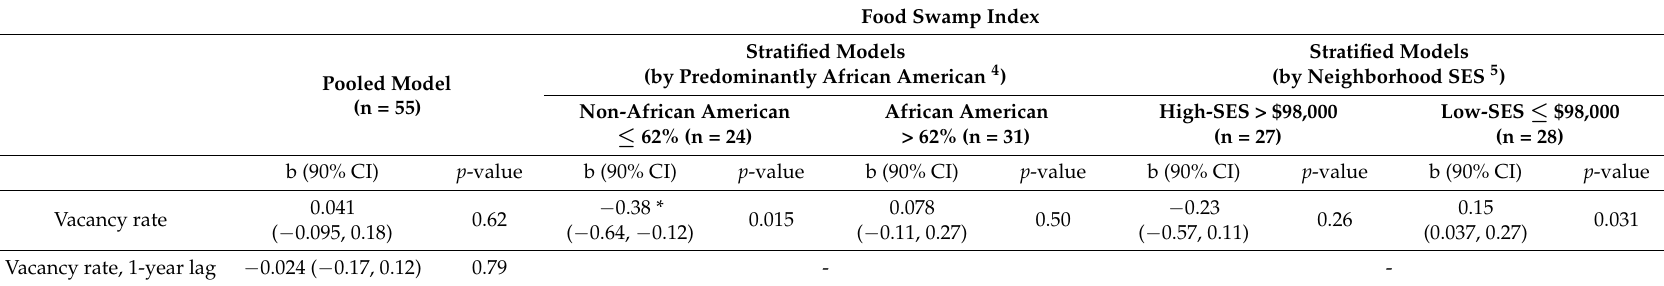
Table 2. Neighborhood fixed effects linear regression 1 for the relationship between changes in vacancy rates 2 and changes in the food swamp index 3 in Baltimore, MD, over the study period from 2001 to 2012. Results are from the pooled model and stratified models by African American neighborhoods and neighborhood